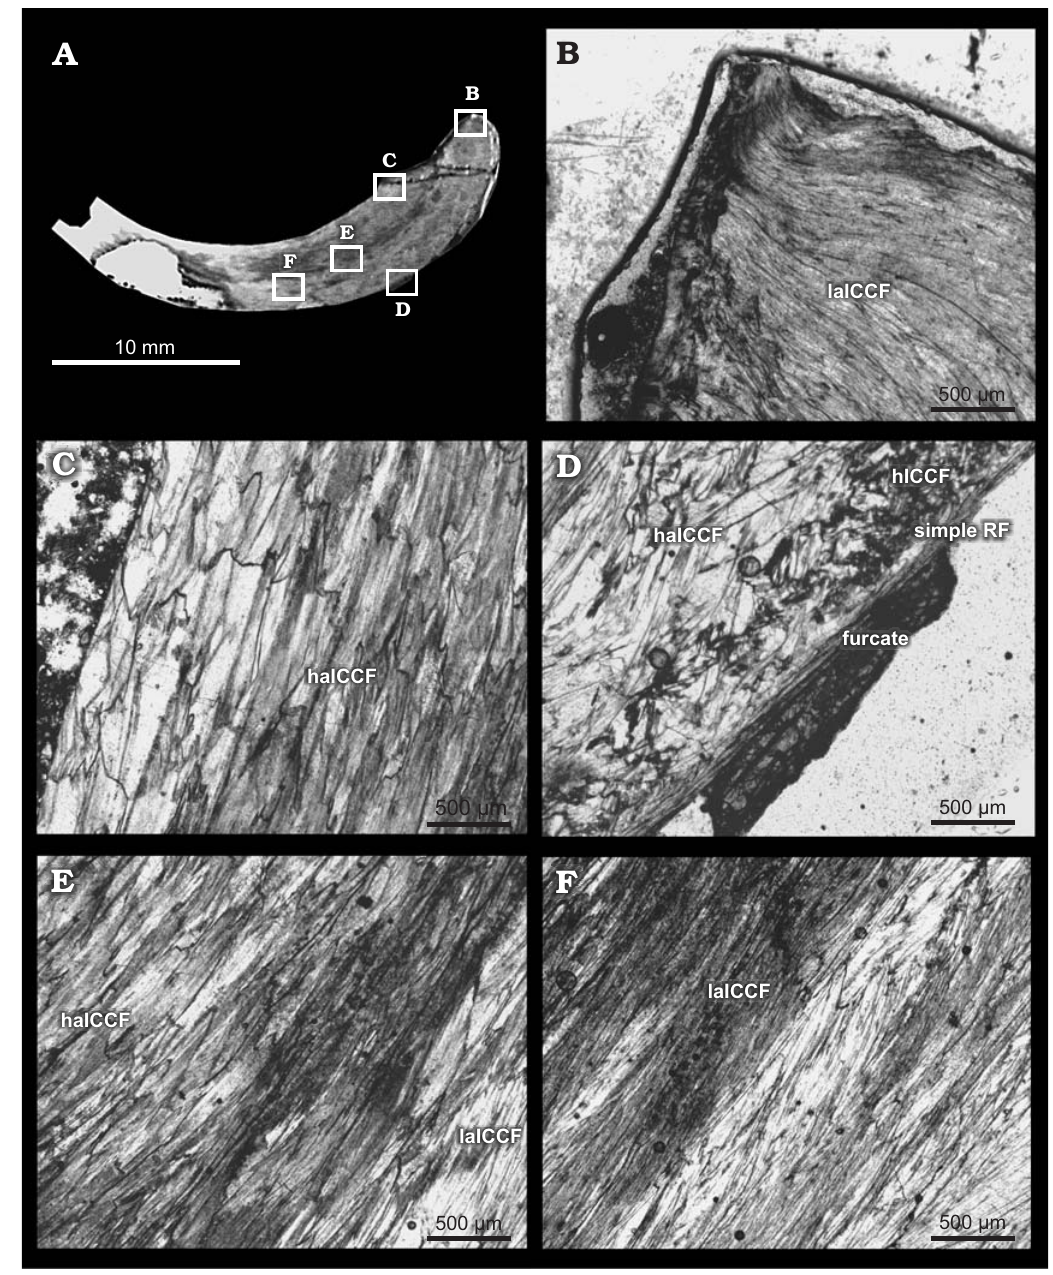
Fig. 6. Shell microstructure of pycnodontein oyster Pycnogryphaea weberae (Yanin in Tschelzova, 1969) from Berriasian of Crimea, section Balki village, Dalmasiceras tauricum Subzone. Thin section K-151-29 of left valve TsSGM 2088/35 with locations of photomicrographs (A); umbonal region repre- sented by laCCF (B); internal part represented by haICCF (C); external part: endostracum consists of “furcate” microstructure, simple regular foliated microstructure (simple RF), hICCF and haICCF (D); central part represented by laICCF and haICCF (E, F). haICCF, high angle irregular complex crossed foliated microstructure; laICCF, low angle complex crossed foliated microstructure; simple RF, simple regular foliated